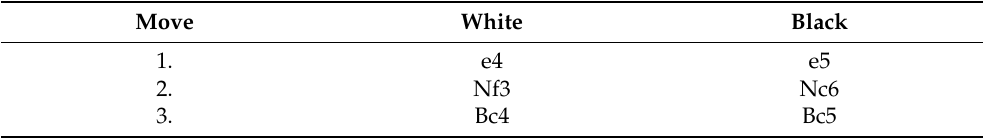
Table 3. Classical format of a chess game notation. Move